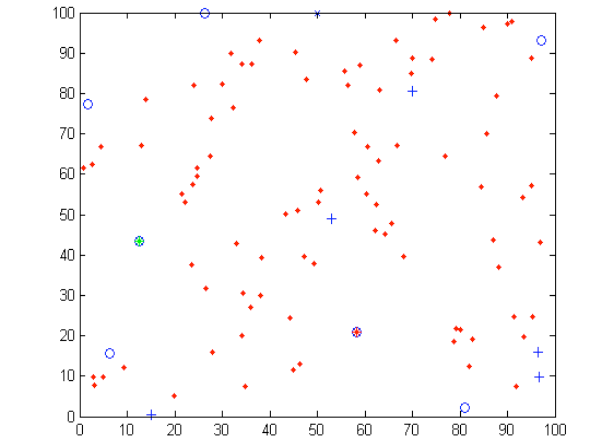
Fig. 6. Simulation with EDE